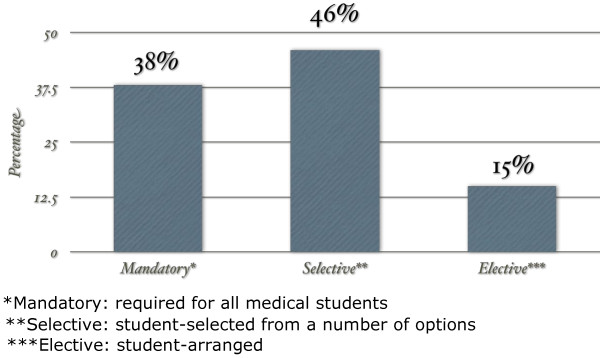
Clerkship structure.